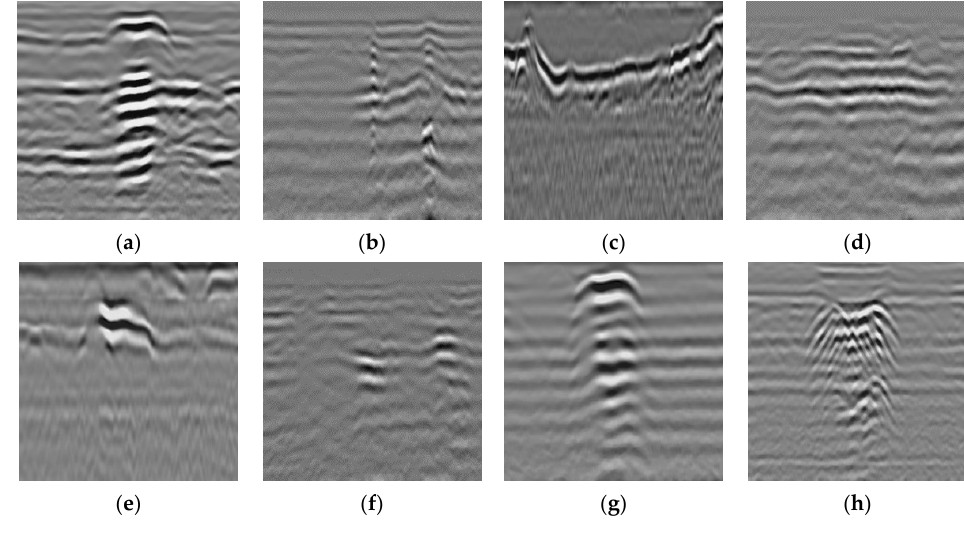
Figure 6. Filtered and enhanced GPR images 1 − 8 ( a − h ). In order to further suppress the background noises, the image contrast at high gray values is enhanced by gamma transformation. In order to observe the grayscale distribu- tion in the image more intuitively in the experiment, the color distribution is divided in- to 128 color bins and the grayscale histogram distribution of the images is calculated as shown in Figure 7. The highlight feature of abnormal information means that abnormal information is mostly distributed in higher gray levels in grayscale images. As shown in the second column, (b), (f), (j), and (n) in Figure 7, the grayscale histogram distribution of the image before Gamma transformation is relatively uniform, which means that the abnormal information of interest is not obvious compared with the background. The background information is too complex to extract effective information. After the Gam- ma transformation with a coefficient of 5, the overall brightness of the images becomes dark, as shown in the third column, (c), (g), (k), and (o) of Figure 7, and the grayscale histogram of the fourth column, (d), (h), (l), and (p) of Figure 7, shows that in the origi- nal images most of the low gray value points in the images are adjusted to 0 after Gam- ma transformation, and the more complex and low gray value background is sup- pressed so that the abnormal high brightness regions are visually highlighted. Excessive Gamma transform coefficients may cause some effective signals to be misjudged as background signals and adjusted to zero, and the overall picture is darker, resulting in poor visual effect, which is not conducive to the extraction and construction of visual at- tention features in later steps. The experimental results show that the suppression effect on the background noises of the GPR images is more obvious when the Gamma coeffi- cient is 5, and the loss of effective info